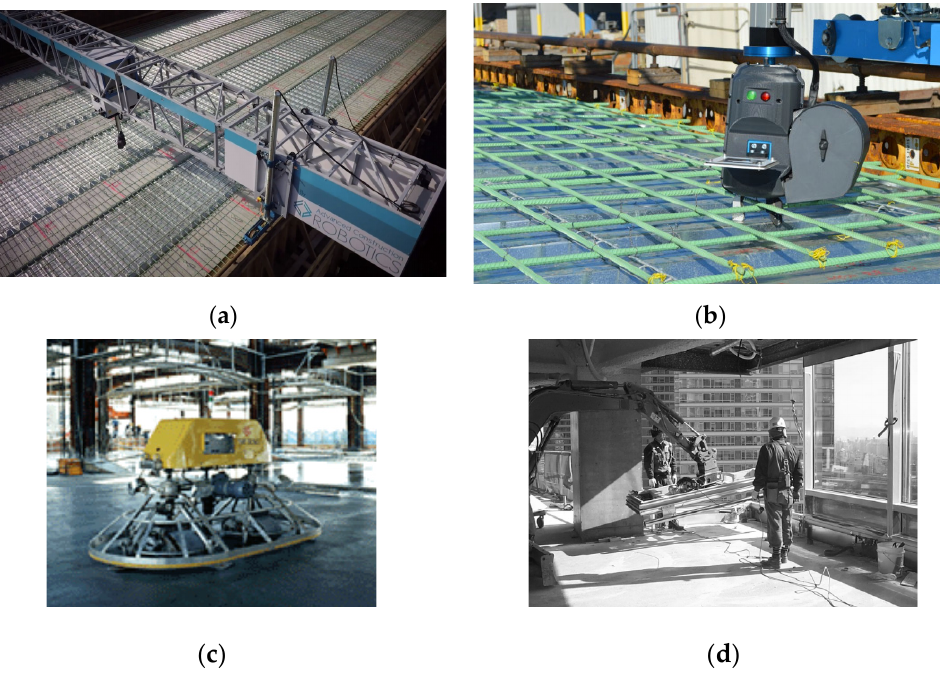
Figure 8. ( a , b ) Rebar tying Robots [131–133]; ( c ) Concrete surface compacting robot [127,134]; ( d ) Façade wall modular installation robot [135,136]. ( d ) Façade wall modular installation robot